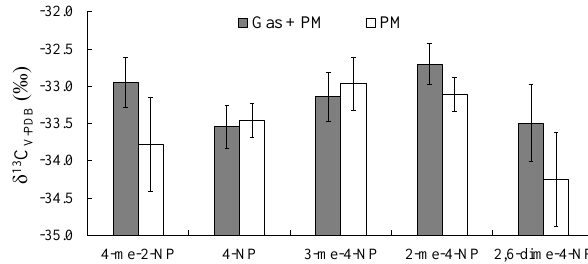
Figure 5. Comparison of average isotope ratios of nitrophenols found in PM alone and in the gas phase + PM. The error bars rep- resent the error of the